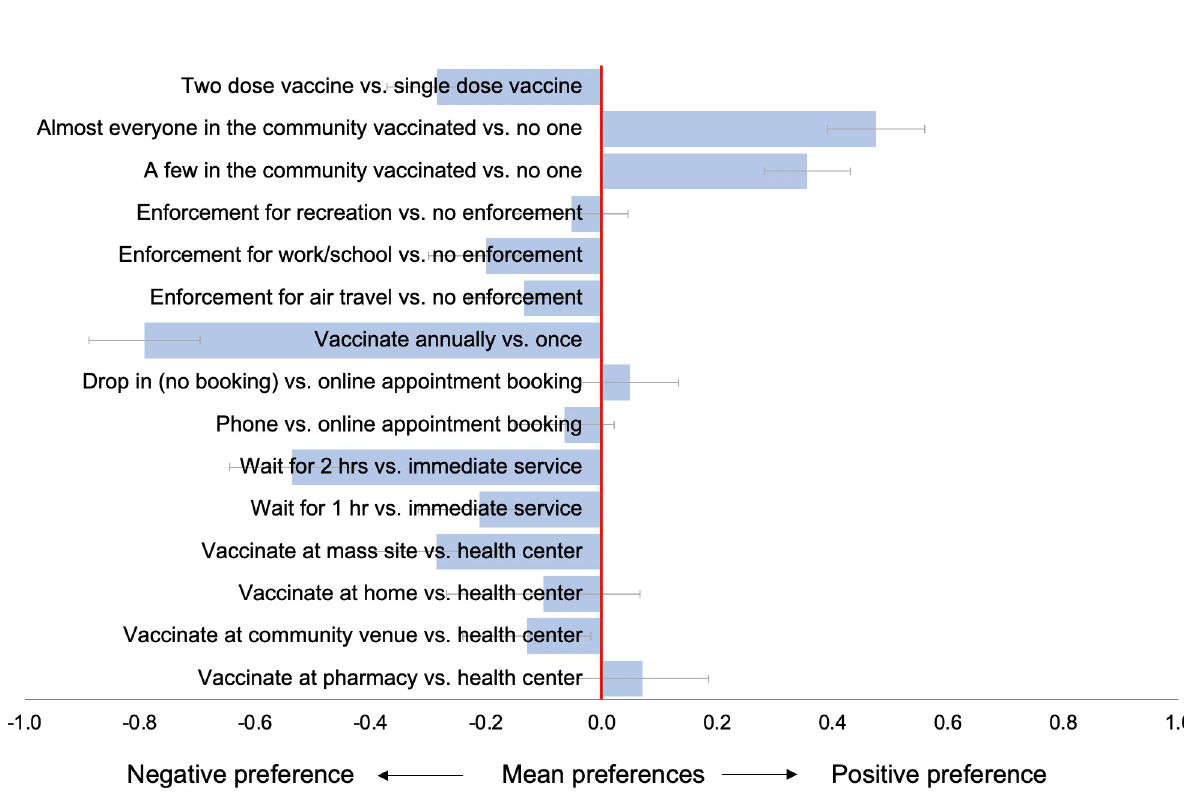
Fig 2. Weighted mean preferences (relative utilities) for vaccination campaign features, in total population (N = 2,985).